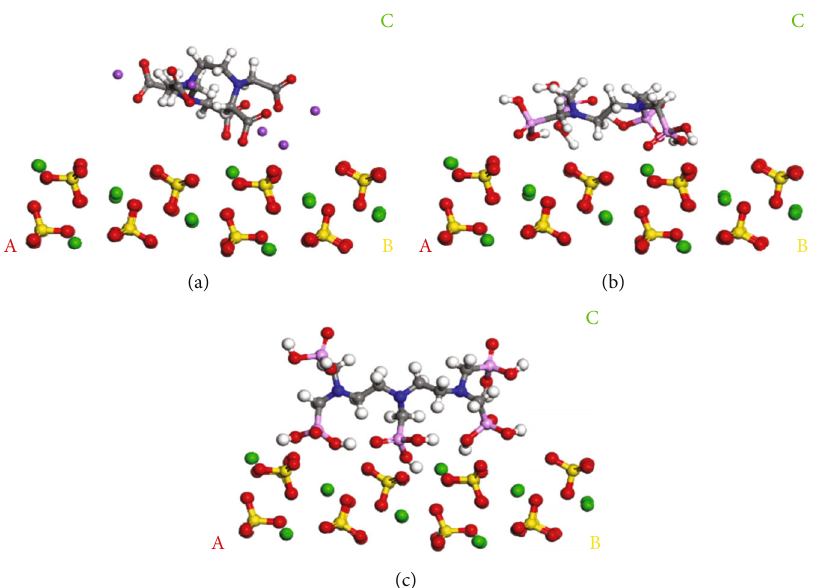
Figure 7: (101) Surface of barium sulfate is interacting with (a Table 4: Adsorption energy (KJ/mol) of models of inhibitor-BaSO